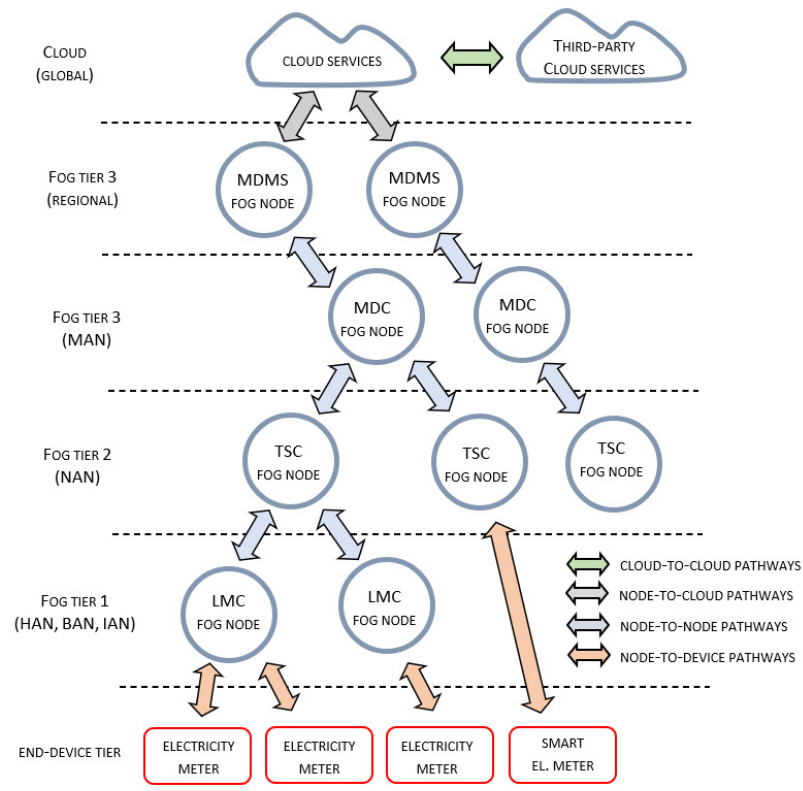
Figure 1. Tiered AMI architecture based on fog computing.